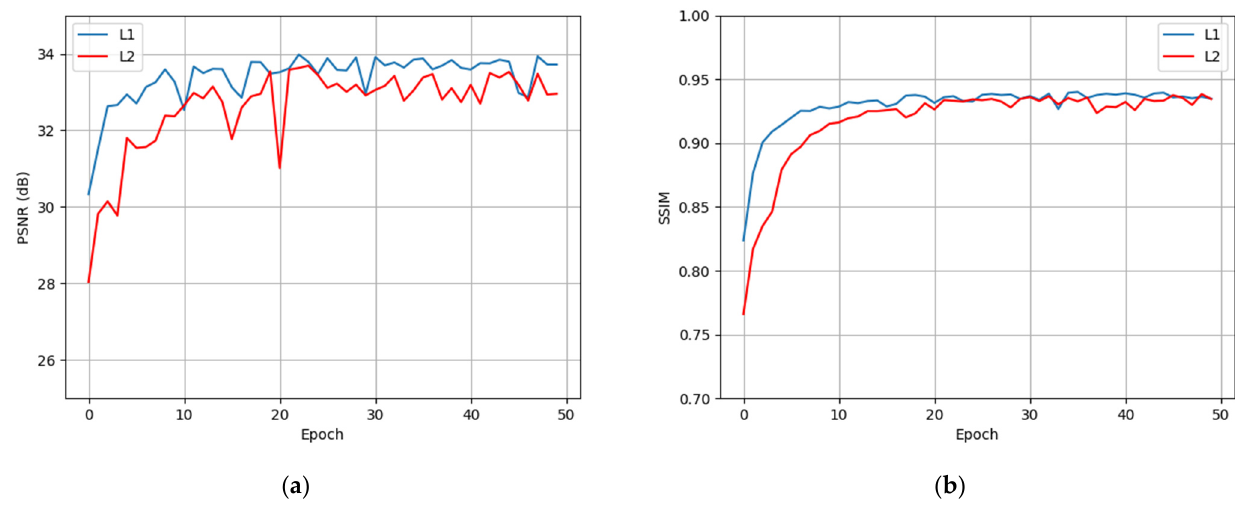
Figure 11. Quantitative metrics of different loss functions in the training stages. ( a , b ) Respectively, show the change of PSNR and SSIM with the increase in epoch. The blue curves in ( a , b ) denote that the model is optimized by l 1 loss, and the red curves are for l 2 loss.